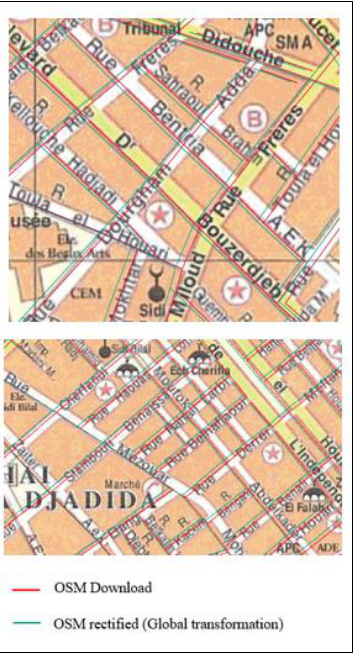
Figure 13. OSM network before and after geometric correction using global